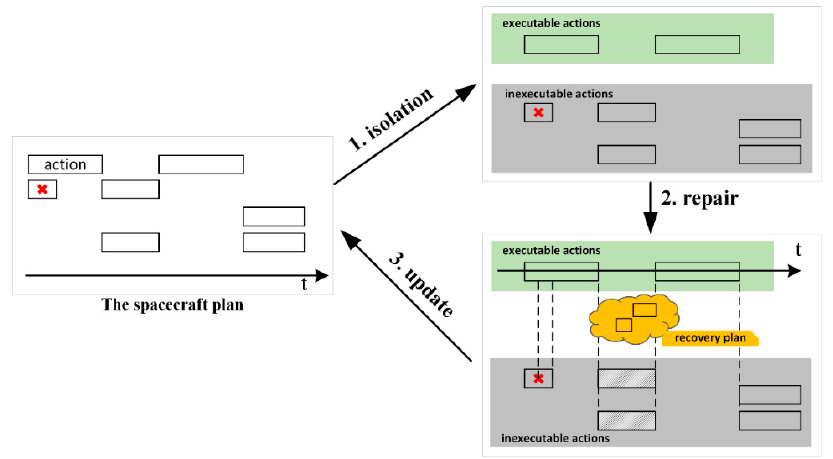
Figure 1. Sketch of IRPF. All rectangular boxes in the figure represent actions.